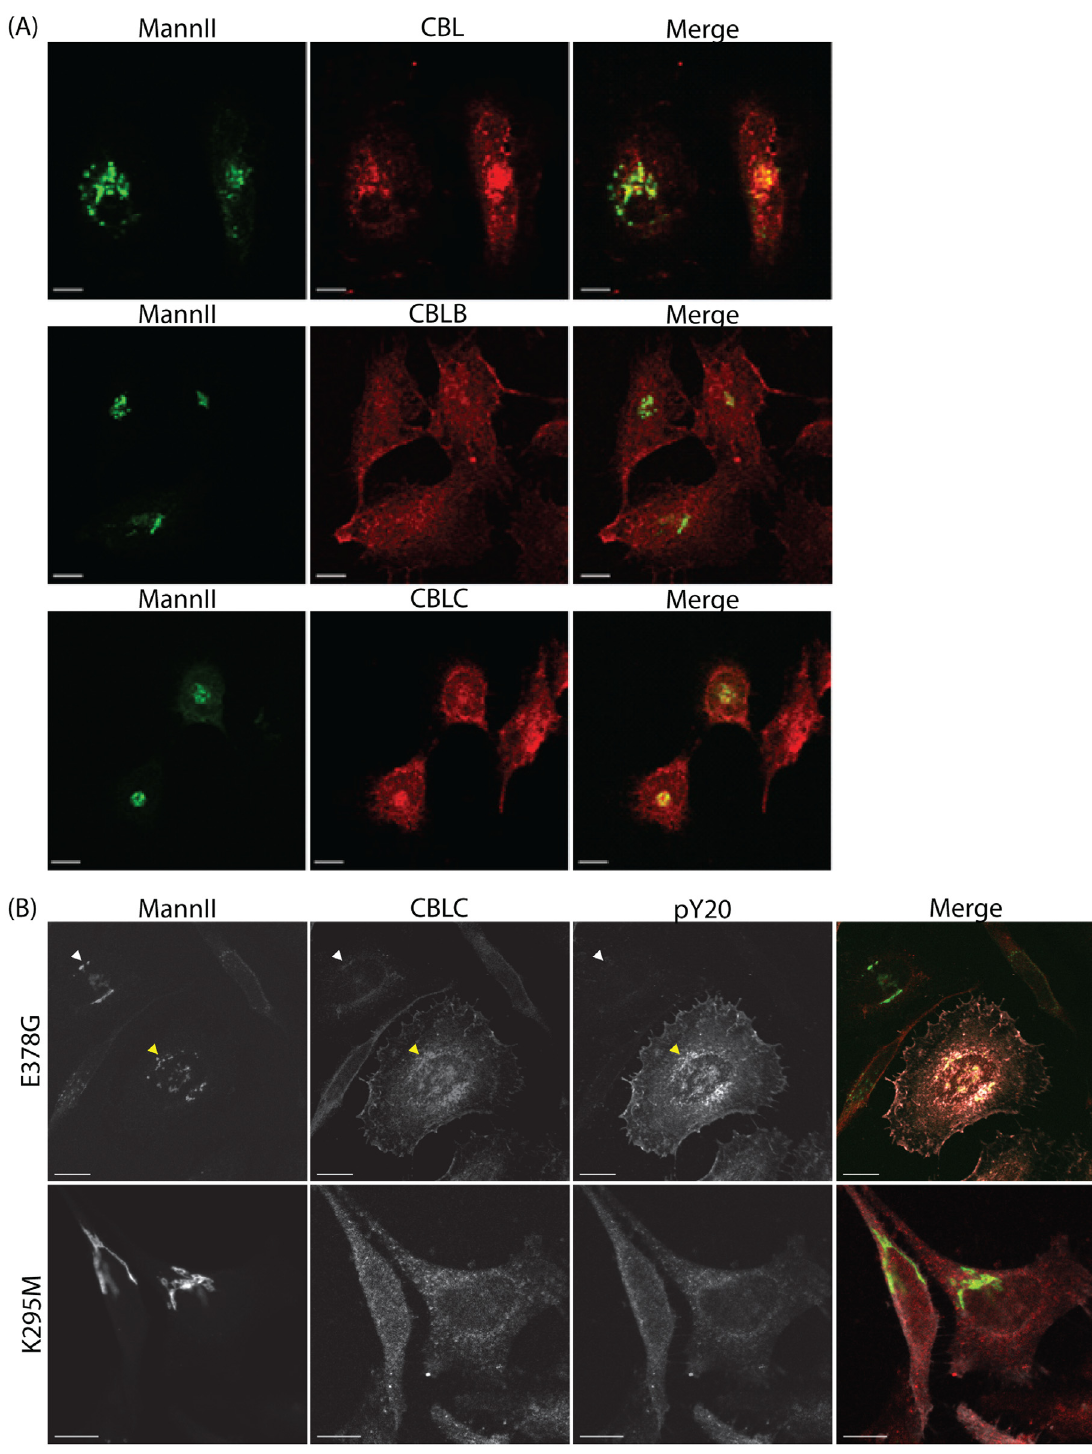
Fig 4. SRC recruits CBLC to the Golgi apparatus. (A) CBL and CBLC localize to the Golgi apparatus. MannII-GFP and endogenous CBL, CBLB, or CBLC staining in HeLa cells. (B) SRC activation enhances recruitment of CBLC to the Golgi apparatus. Cells were transfected with either constitutively active SRC E378G or inactive SRC K295M. Staining for tyrosine-phosphorylated proteins stained with pY20 (white) to report SRC transfection and for endogenous CBLC (red). CBLC level at the Golgi was increased in cells overexpressing active SRC (yellow arrow) but not inactive SRC. Scale bar = 10 μ m.